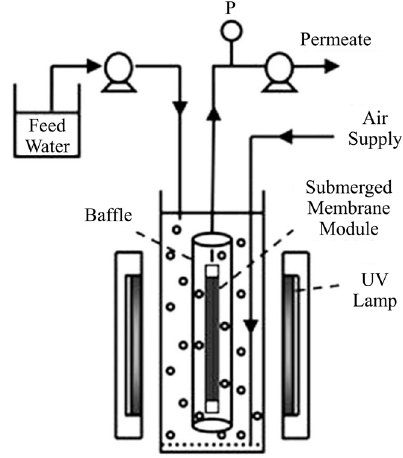
13 of 30 Figure 10. Schematic diagram of a typical lab ‐ scale integrative PMR with UV lamps inside the reactor. Adapted with permission from [73], Copyright Elsevier, 2006. Figure 11 presents a different configuration of integrative PMR. The system was used to remove pharmaceuticals and endocrine disrupting chemicals in water [77]. In this system, 7 UV lamps were positioned surround the reactor instead of submerged in the photocatalytic suspension. The reaction tank was a cylindrical rig that possessed a total working volume of 4 L. Polyvinylidene fluoride hollow fiber membranes were potted to provide 100 cm 2 of membrane surface. The membrane module was positioned in the center of the reactor. A peristaltic pump was employed to extract permeate from the membrane. Transmembrane pressure was measured by a pressure transducer. Membrane filtration was initiated immediately after TiO 2 photocatalyst was added into the reactor under UV irradiation. During the experiment, the flux was maintained at a constant value, and the permeate was withdrawn continuously while equal quantity of feed water was supplied to the reactor. Aeration was supplied at the bottom of the reactor for the same purposes as those in the integrative PMR exhibited in Figure 10. The temperature was maintained around 25 °C during the reactions. The results showed that all the tested compounds except tris(2 ‐ chloroethyl) phosphate were eliminated to various extends. Direct filtration experiment revealed that hydrophobic